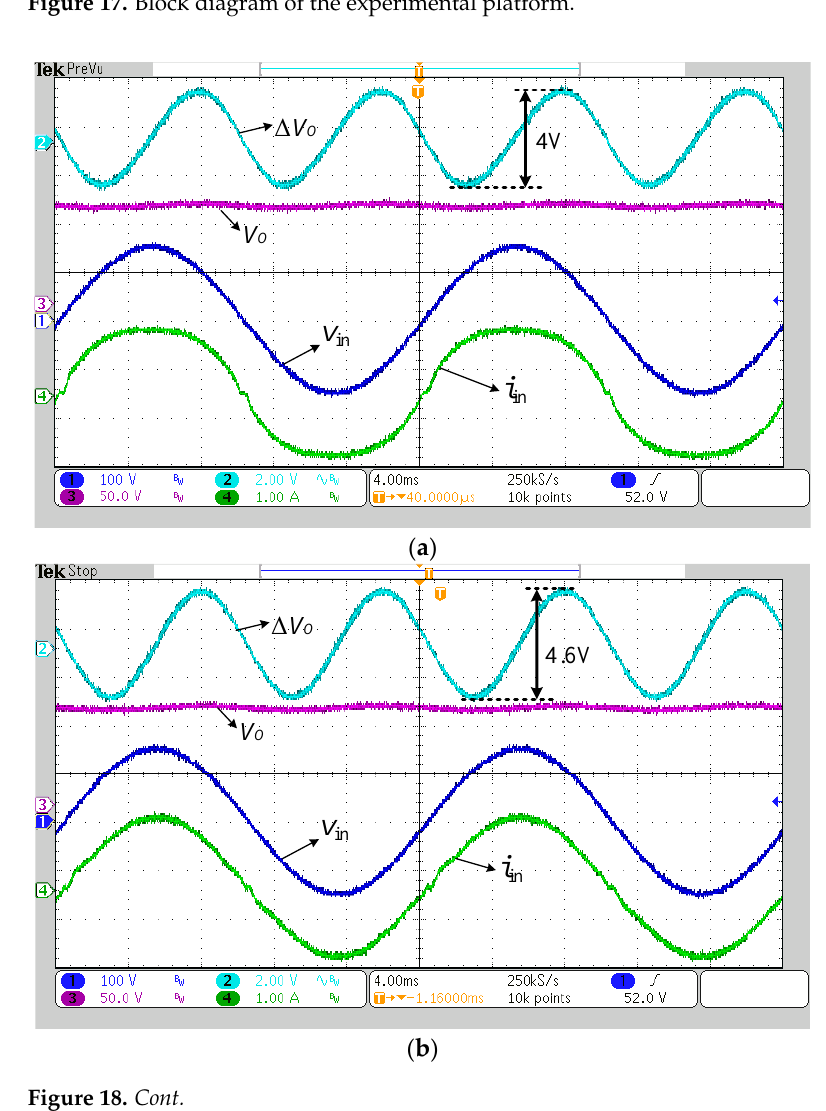
Figure 17. Block diagram of the experimental platform.